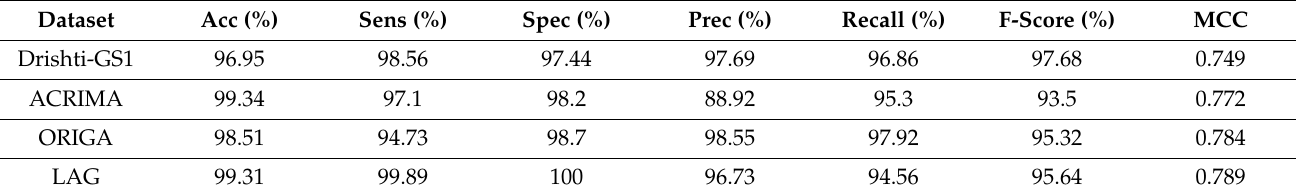
Table 6. Performance of the proposed method employing DBN and